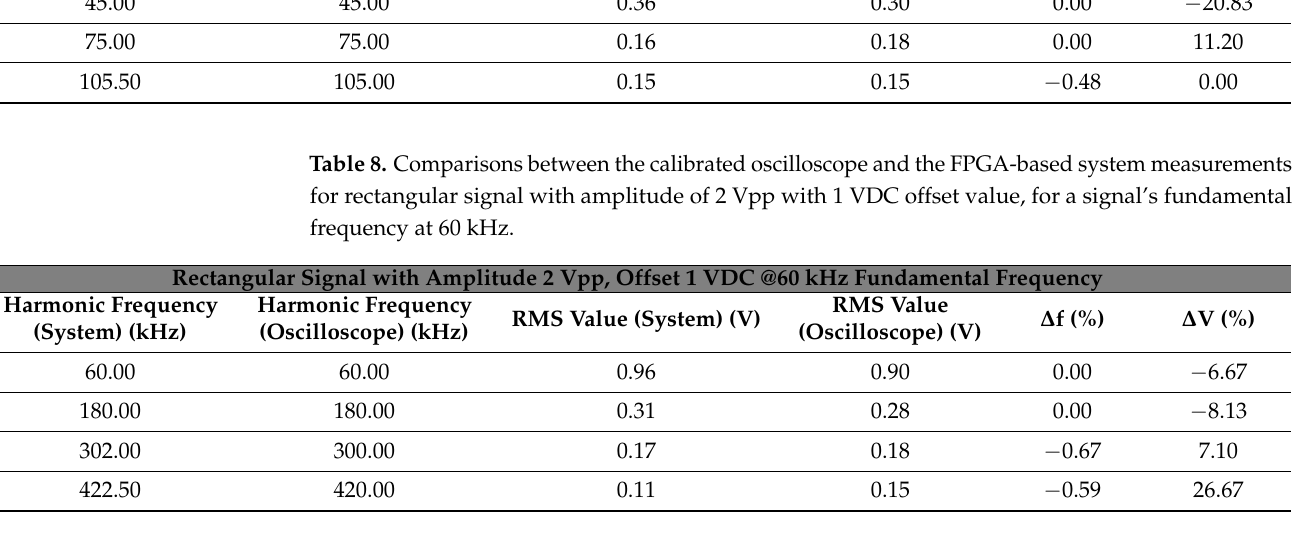
Table 9. Comparisons between the calibrated oscilloscope and the FPGA-based system measurements for rectangular signal with amplitude of 2 Vpp with 1 VDC offset value, for a signal’s fundamental frequency at 150